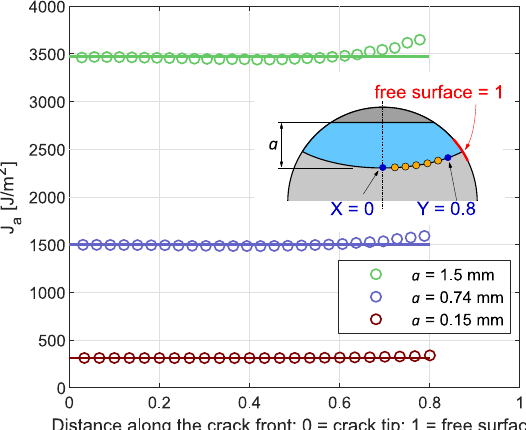
Figure 10. Change of elastoplastic J-integral for selected crack lengths in 304L in the case of cyclic test with total strain amplitude ε a = 0.4%.